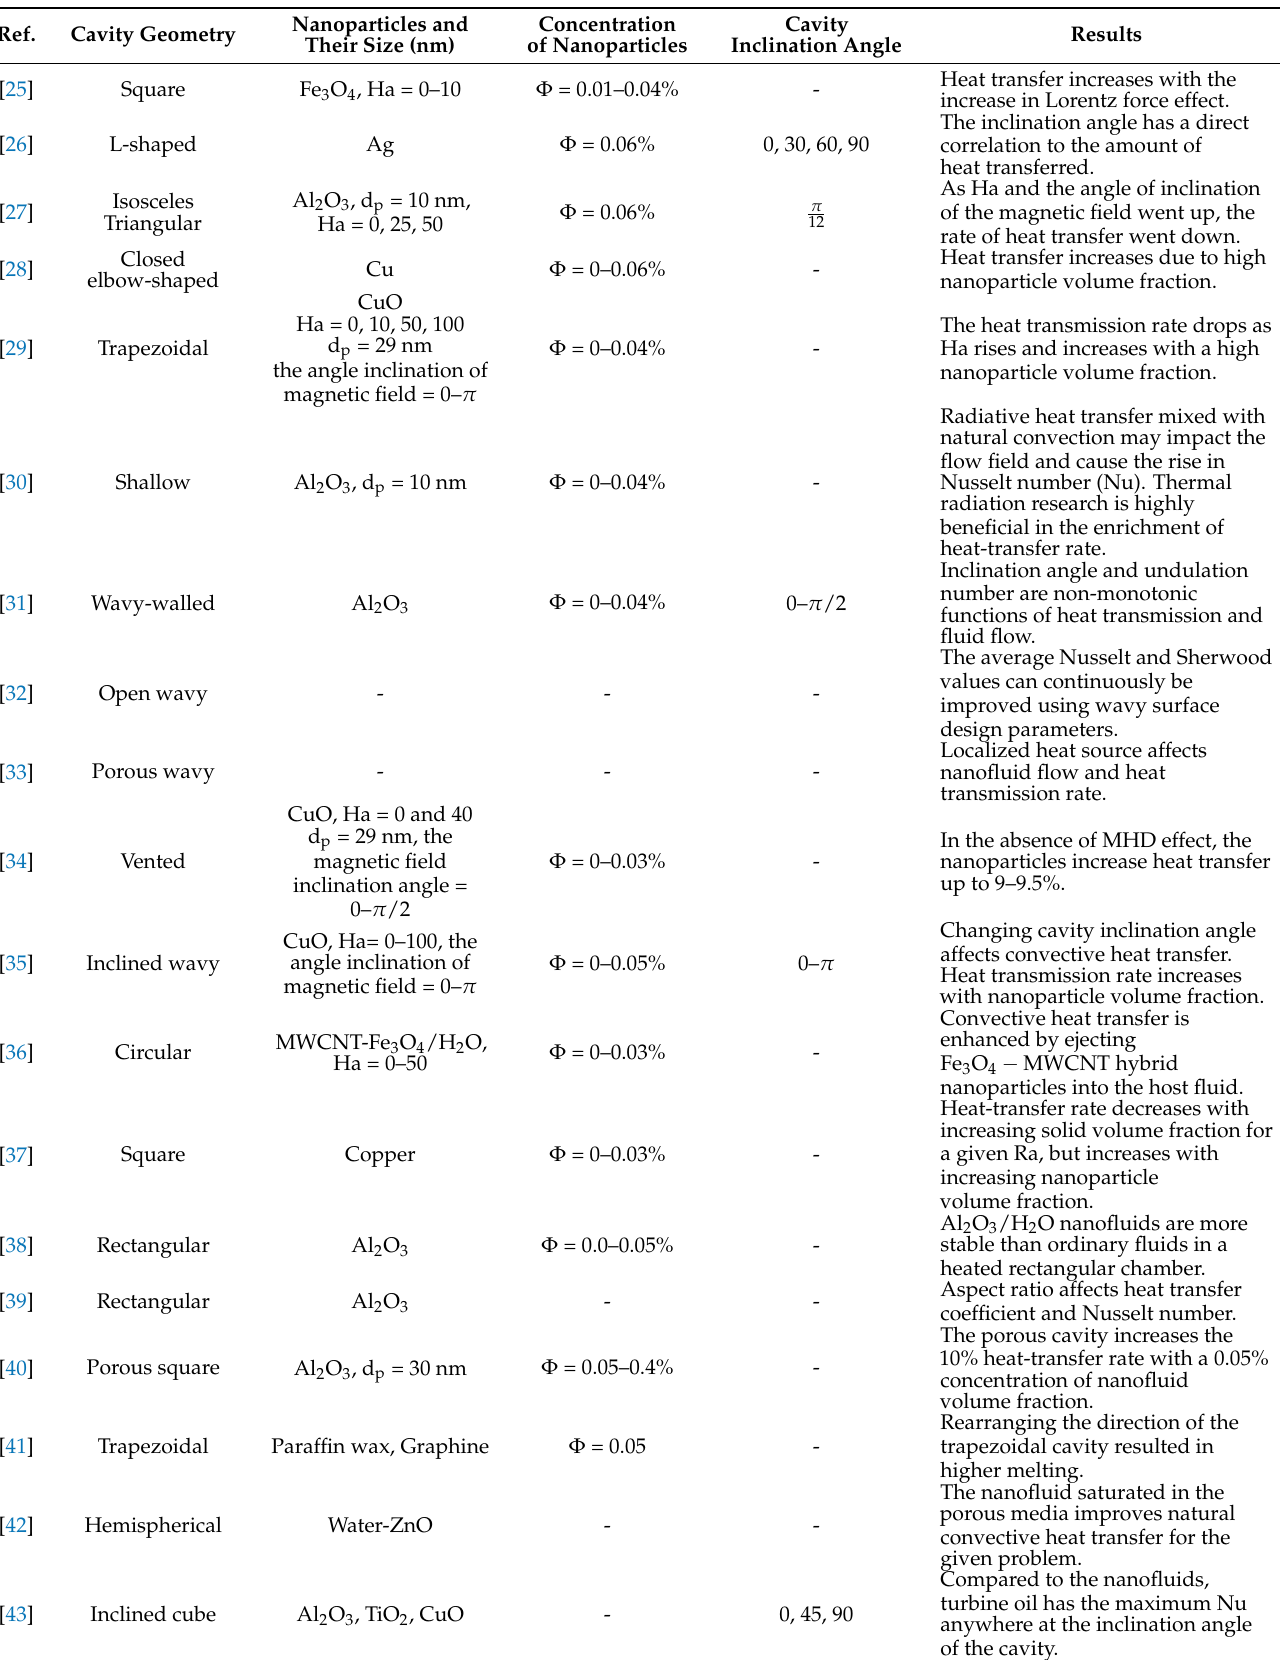
Table 1. Information on different shapes of cavities studied in nanofluid